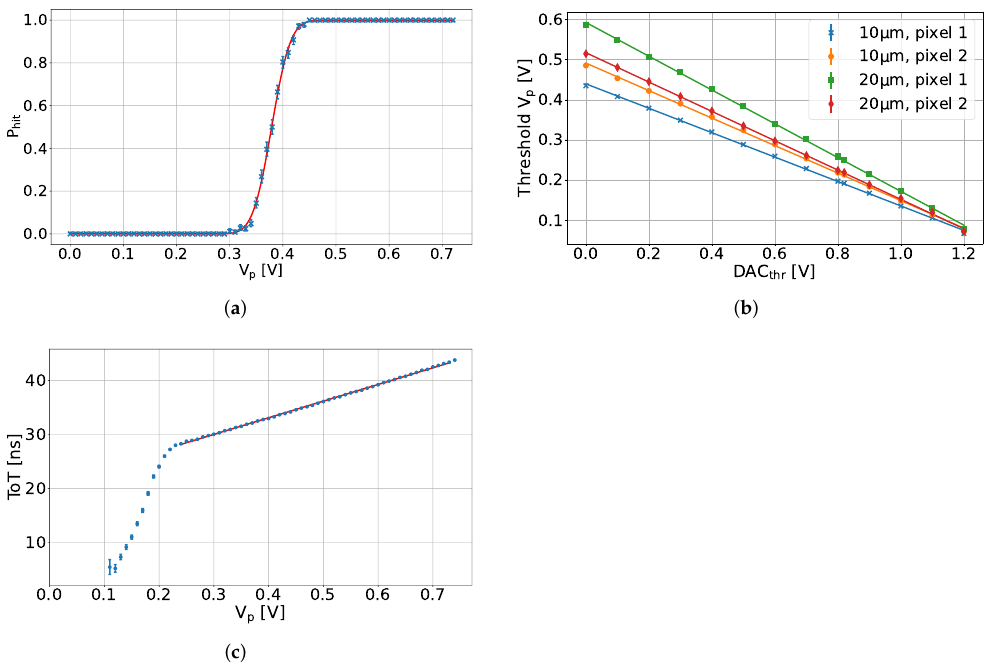
Figure 7. ( a ) Response of pixel 1 in the 20µm pitch matrix at a fixed threshold of DAC thr = 500mV for different pulse amplitudes. ( b ) Measured threshold versus threshold setting for both pulseable pixels of a 10µm and 20µm pitch matrix. The threshold increases with smaller values of DAC thr . ( c ) ToT response of pixel 1 in the 10µm pitch matrix at a fixed threshold of DAC thr = 1000mV. Assuming a design value of 57 aF (10 µm pitch) and 54 aF (20 µm pitch) for the injection capacitance, the conversion factor from pulser voltage to injected charge is 356 e/V (10 µm pitch) and 337 e/V (20 µm pitch), which was used to calculate all threshold values stated here. The values are calculated from the mean of both pulseable pixels with the